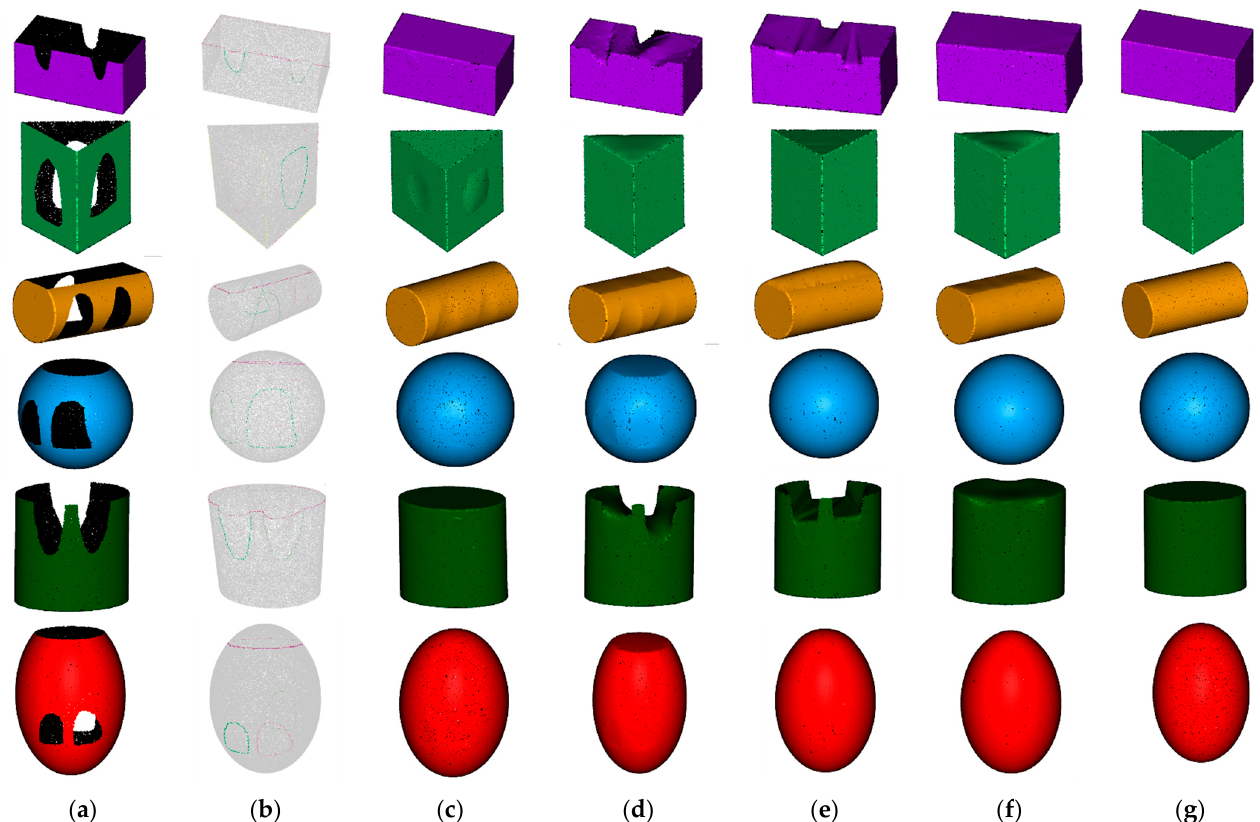
Figure 14. Repair effect of simulated point cloud model: ( a ) before repair; ( b ) hole detection result with our algorithm; ( c ) ours; ( d ) DC-AB scanner; ( e ) Meshmixer; ( f ) Geomagic; ( g ) ground truth.